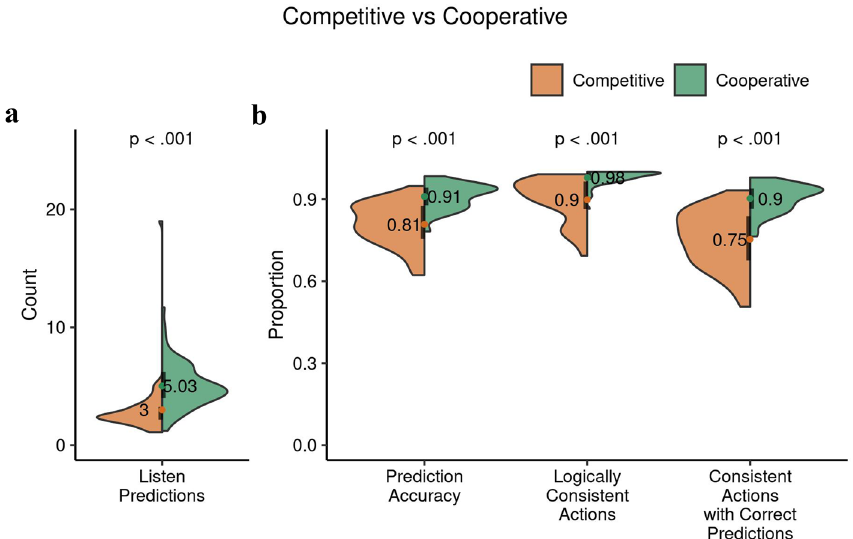
Figure 11. Behavioral indices of prediction: comparison of the competitive and cooperative ITT. Mean values with their distributions in the form of split violin plots. The black bars cover the interquartile range. In ( a ), the number of listen predictions are significantly higher in the cooperative context. In ( b ), the higher prediction accuracy in the cooperative ITT indicates that the participants were better able to anticipate others’ choice behavior. Logically consistent actions and consistent actions following correct predictions of others’ choices are important criteria in achieving favorable outcomes in the cooperative context, as seen with significantly higher percentages during